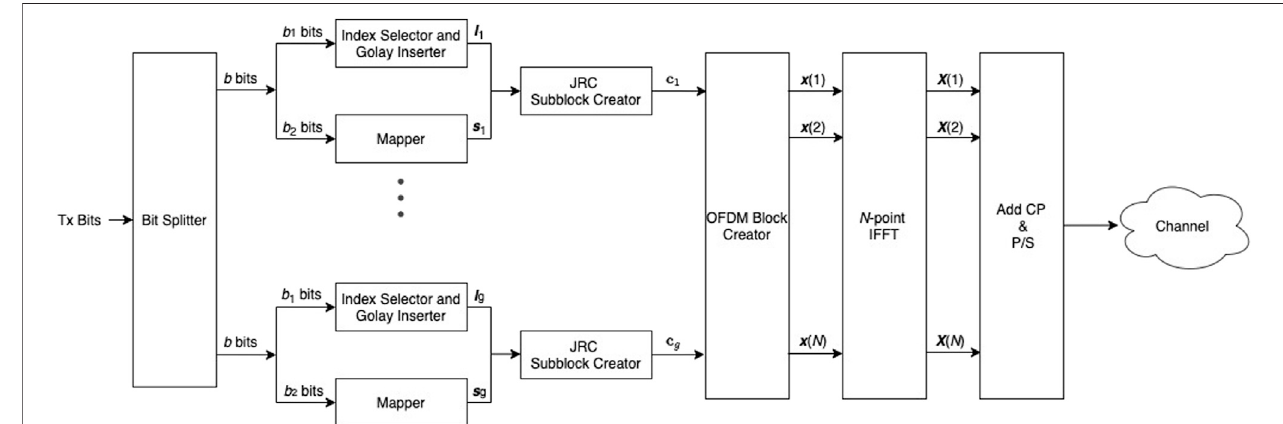
FIGURE 1 | Transmitter structure for the m th OFDM symbol of the proposed DFRC system.